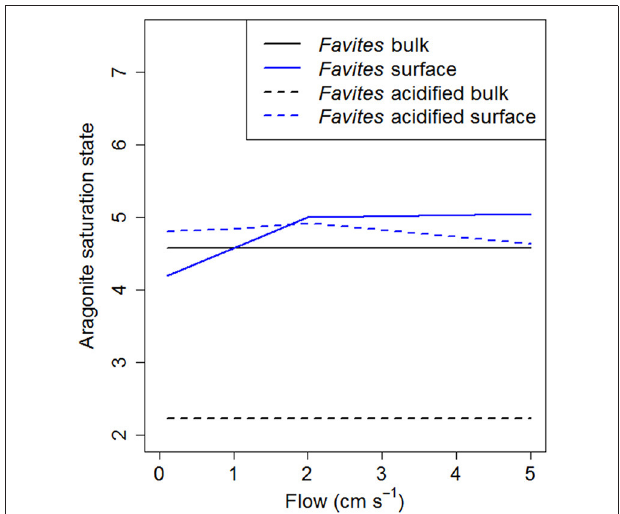
FIGURE 4 | Model predictions of aragonite saturation state at various flows for Favites under ambient (solid lines) and acidified (dashed lines) conditions. Aragonite saturation state of bulk seawater is shown in black and at the tissue surface shown in